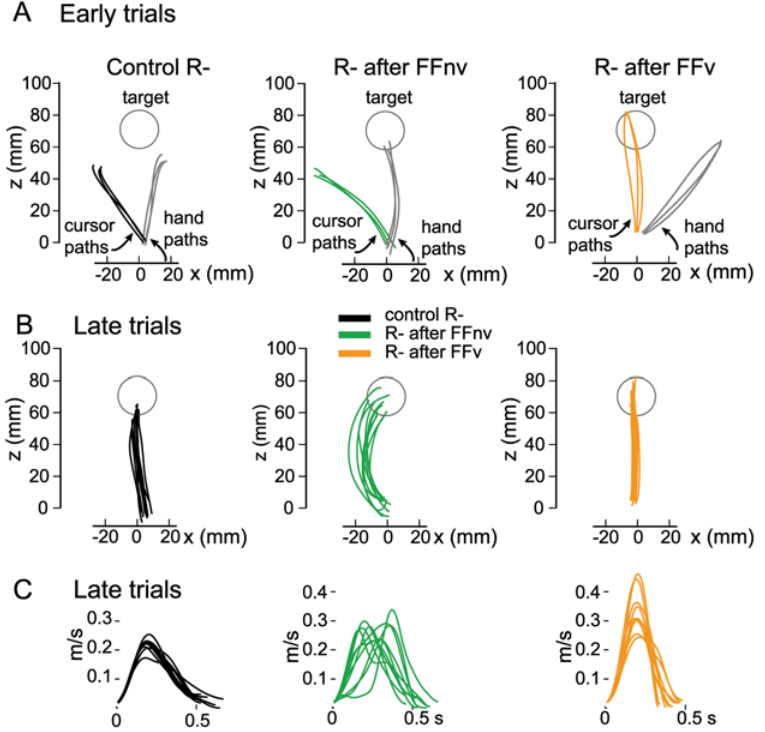
Figure 5. Double perturbations of matched directions: Visuomotor rotation adaptations after force field adaptations. A, Cursor and hand paths of representative subjects (one per group) during the first trial of the first exposure to rotation ( left , Control R 2 ), and following adaptations to force field without visual feedback ( center , R 2 after FFnv) and with ( right , R 2 after FFv). To reach a target at 90 u in visuomotor rotation, subjects should direct their movements 45 u clockwise from the target. Subjects see a rotated cursor feedback of their hand movement and final hand position such that they see the cursor reaching 90 u -target while their hands end at 45 u . Center and right , the hand path of the first rotation trial (solid gray line) are also shown to illustrate aftereffects of prior force field adaptations. B, As in A, cursor paths of the late rotation trials. The hand paths of the subject who had prior adaptation to FFnv were curved (center) as opposed to the straight paths of the subjects in control R 2 and in R 2 after FFv. C, Velocity profiles of the late trials shown in B. The profiles of the subject in R 2 after FFv show that the curved paths were not due to online trajectory corrections, as seen previously in single force fields without VFB.